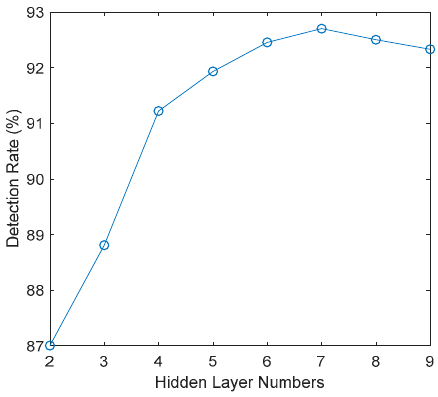
Figure 6. Hidden layer numbers for DBN.